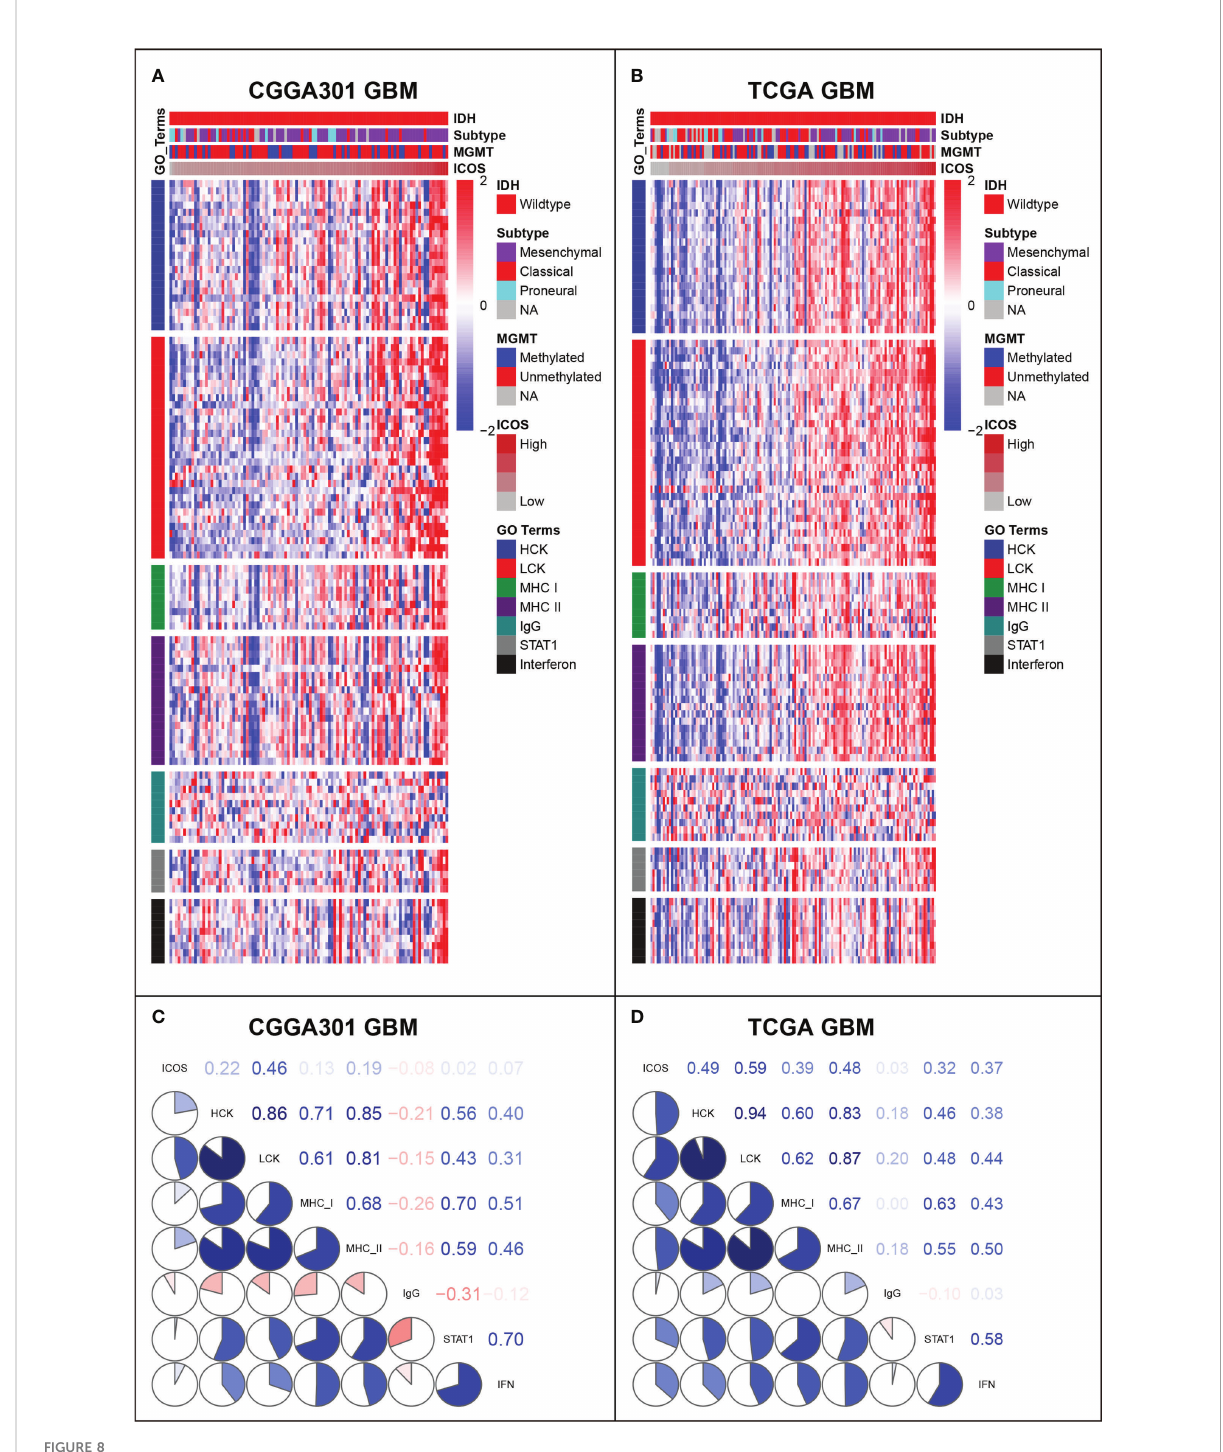
FIGURE 8 Gene Set Variation Analysis (GSVA) of ICOS-related in fl ammatory activities of glioblastoma in CGGA301 and TCGA datasets. (A) Heatmap of representative genes from different in fl ammatory activities in CGGA301 glioblastoma. (B) Heatmap of representative genes from different in fl ammatory activities in TCGA glioblastoma. (C) Intercorrelation between ICOS and seven metagenes in CGGA301 glioblastoma. (D) Intercorrelation between ICOS and seven metagenes in TCGA